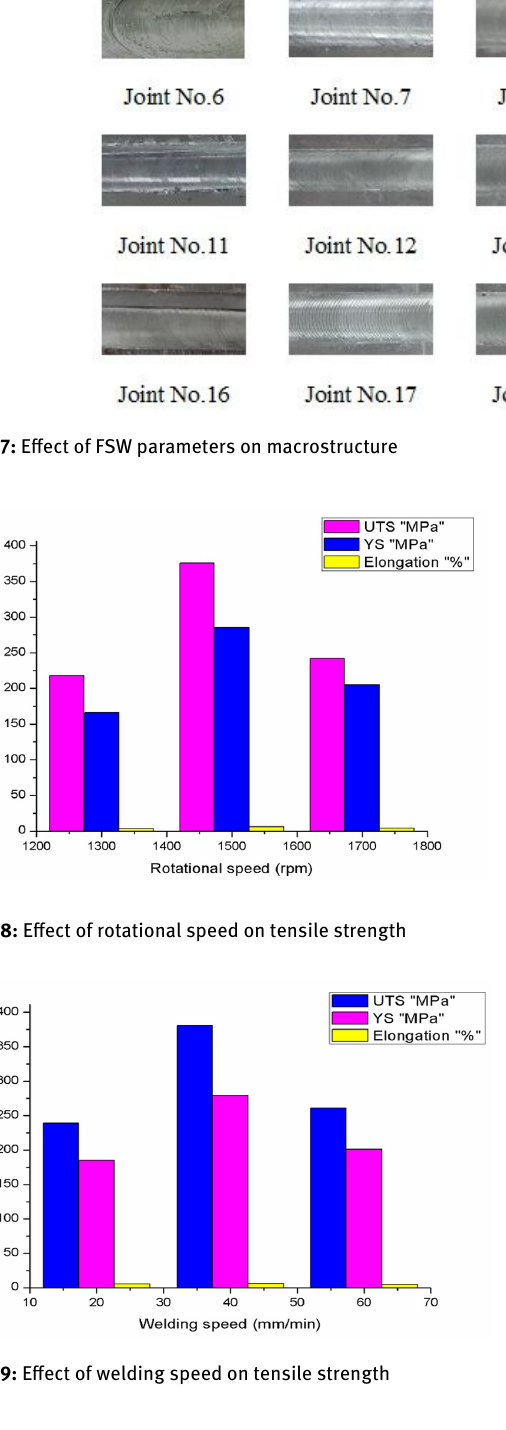
material flow in the SZ, weld region was classified into